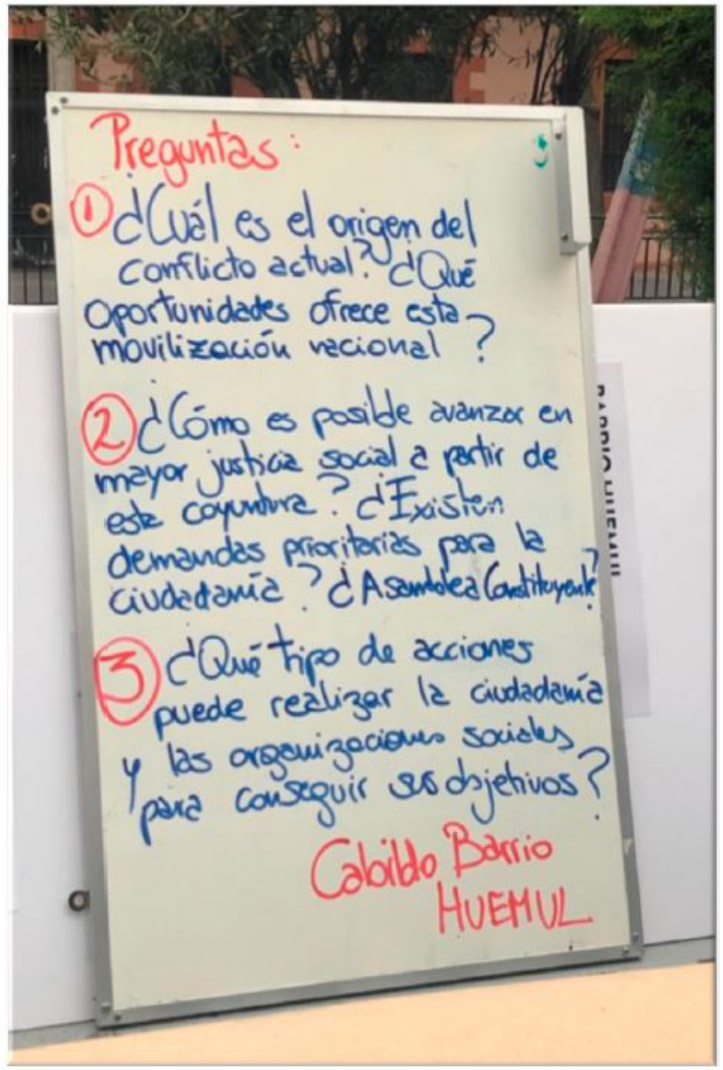
Figure 3 27 October 2019 – Plaza Huemul – community white board with written questions developed by Social Unity that guided cabildo discussions (Source: Author,